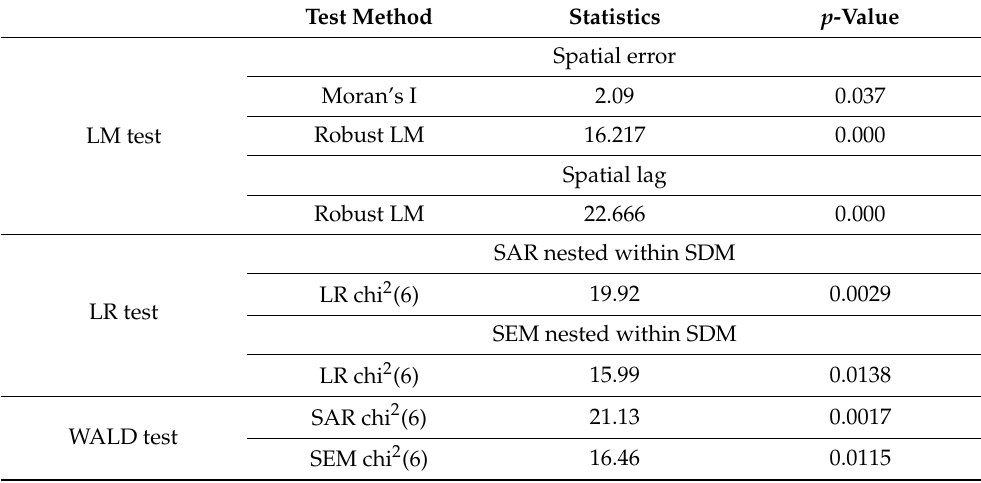
Table 3. The LM, LR, and WALD test